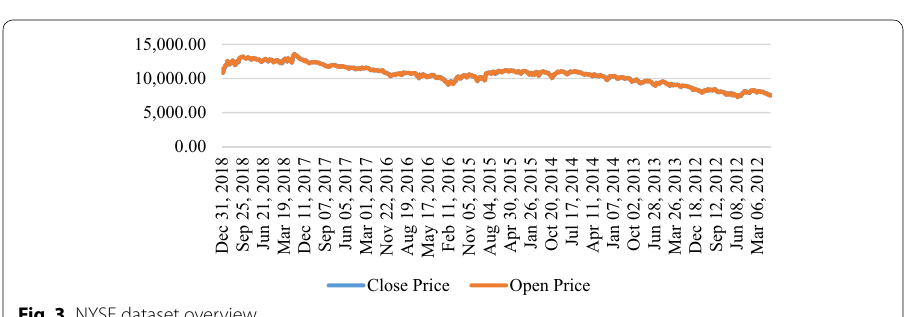
Fig. 3 NYSE dataset